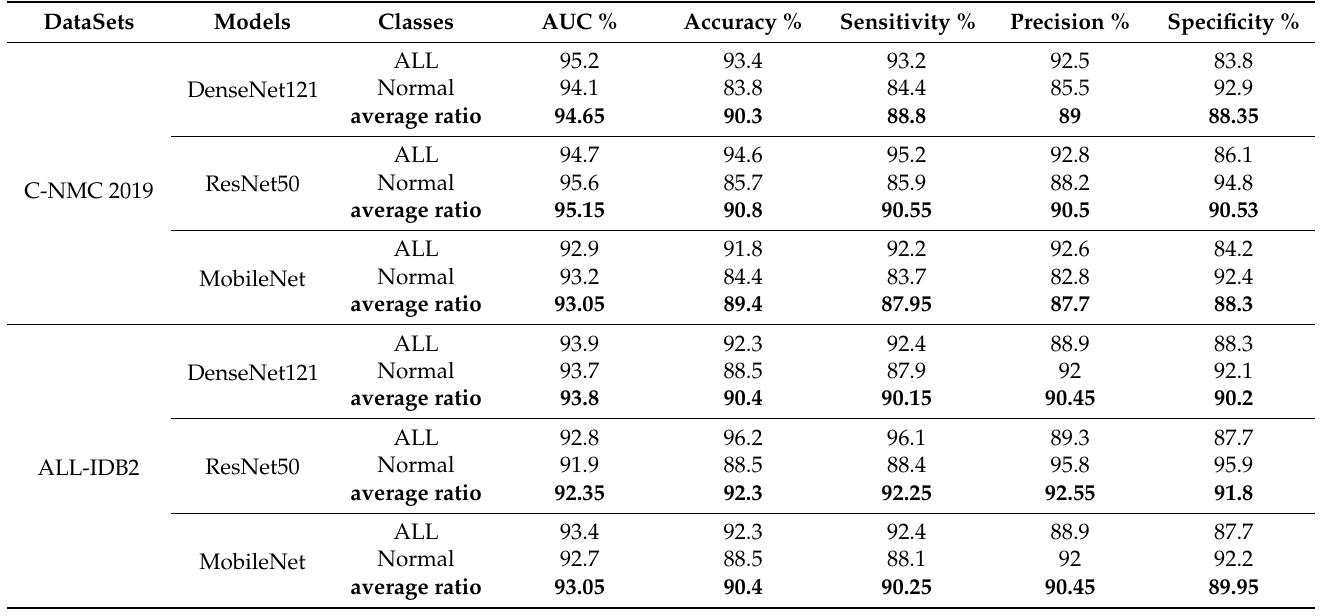
Table 4. Results of DenseNet121, ResNet50, and MobileNet models pre-trained on two datasets, C-NMC 2019 and ALL-IDB2, for acute leukemia diagnosis.